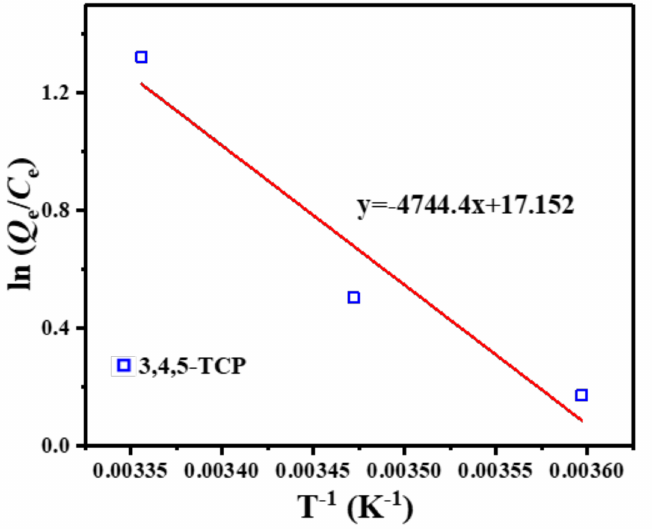
Figure 9. Van’t Hoff graph of 3,4,5-TCP adsorption onto C–O/W microcapsules. Table 3. Thermodynamic parameters for the adsorption of 3,4,5-TCP by C-O/W.